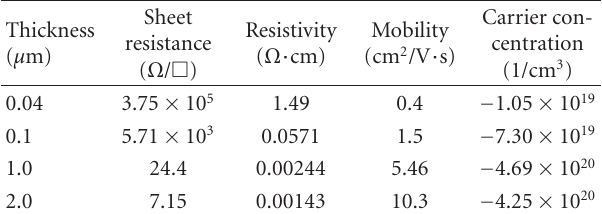
Table 2: Measured electrical properties for ZnO:Al 2 O 3 films grown from ceramic